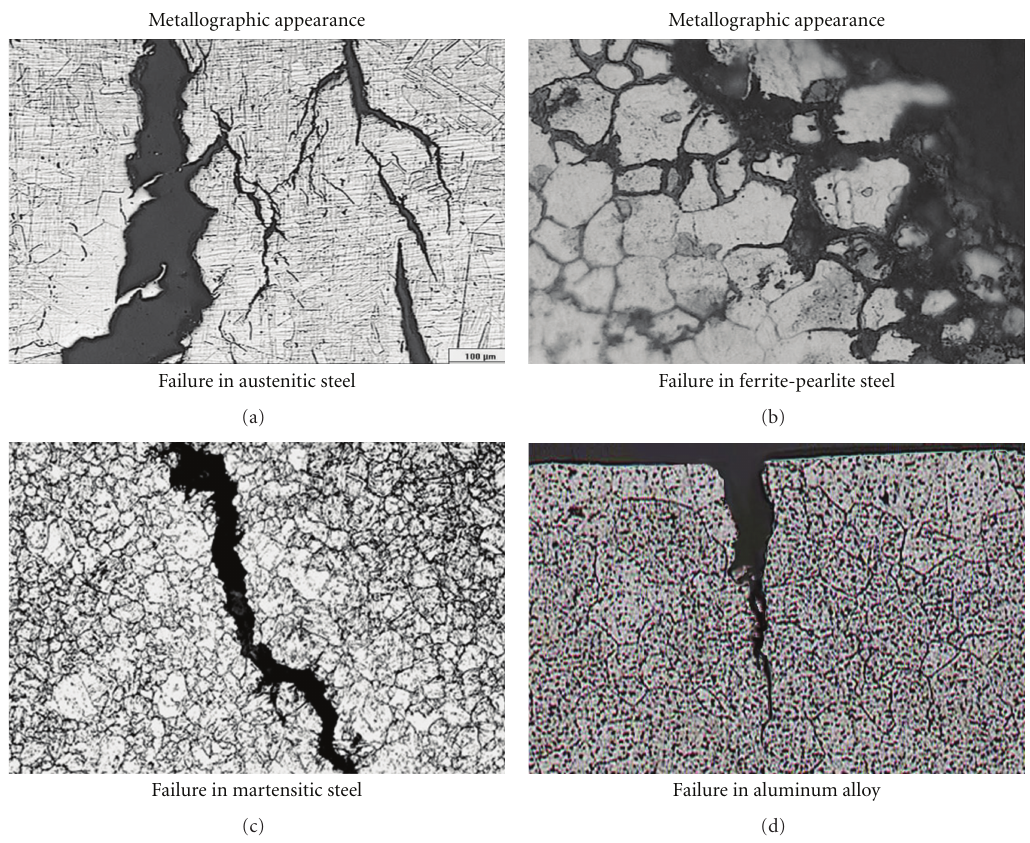
Figure 1: Appearance of the microstructures of samples extracted from field failure